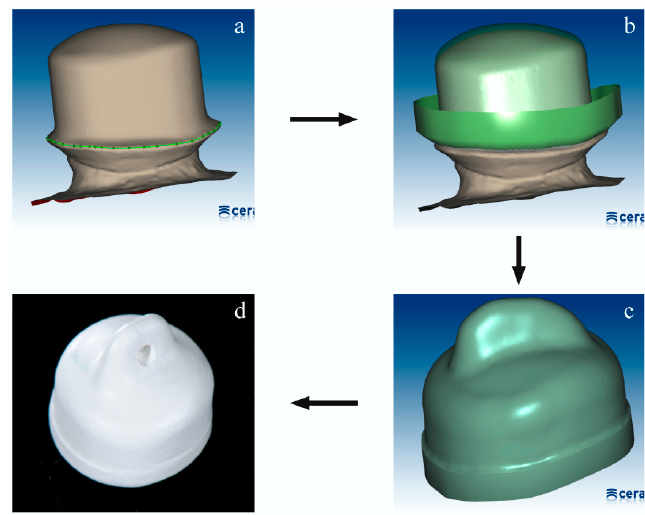
Figure 1. Photo series about CAD/CAM processing a PEEK secondary crown (PM) ( a ) scanned primary crown (0° taper), marked preparation border; ( b ) secondary crown construction; ( c ) setup-wizard of secondary crown with designed retainer; ( d ) milled secondary crown, end result.